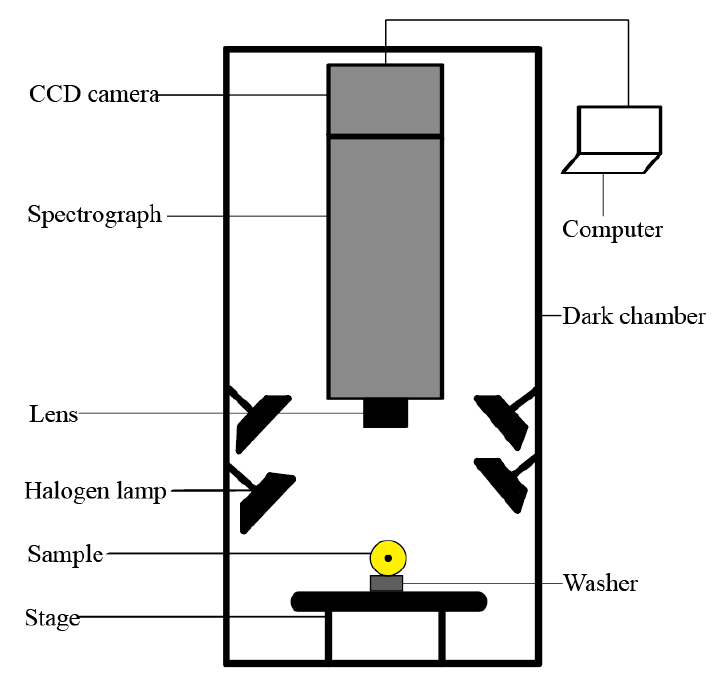
Figure 1. Schematic diagram of the hyperspectral imaging system.